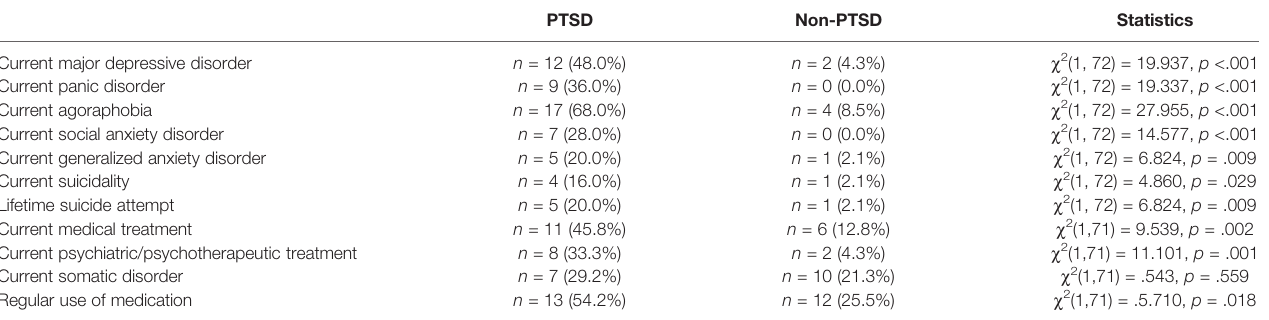
TABLE 2 | Clinical data of the PTSD ( n = 25) and Non-PTSD group ( n =